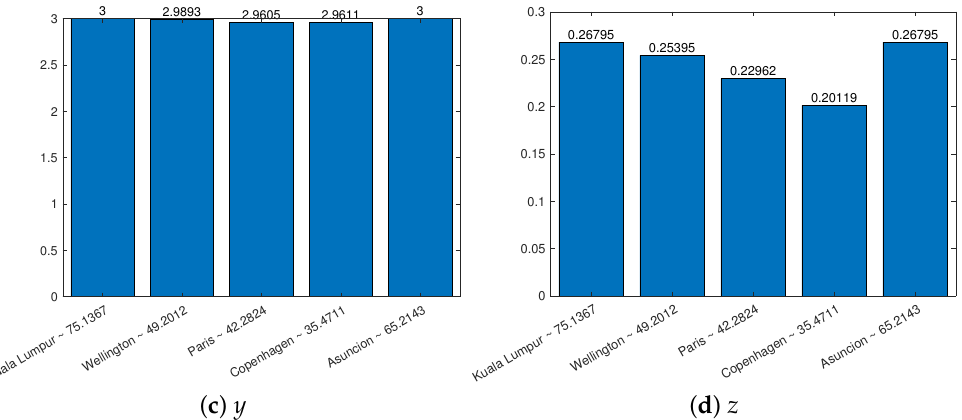
Figure 7. Weighted average values of parameters ( a , b , y , z ) with respect to each region in Table 2. Note that the number displayed after the city is the weighted average value of the south meridian altitude.